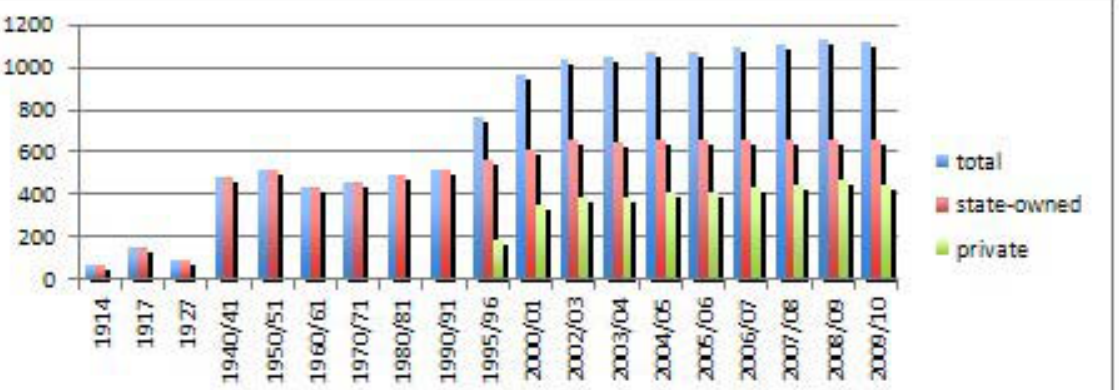
Figure 4 . Number of state-owned and independently operated higher education institu- tions. Source: Федеральная служба государственной статистики [Federal State Statis - tics Service]. http://www.gks.ru/free_doc/new_site/population/obraz/vp-obr1.htm (Re- trieved Jan. 3,